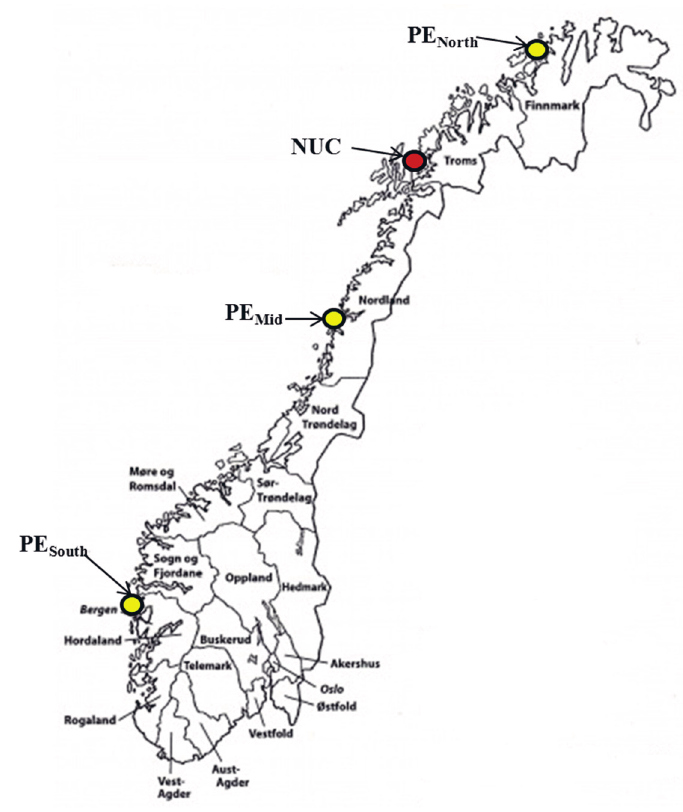
Figure 1. Location of grow out environments in